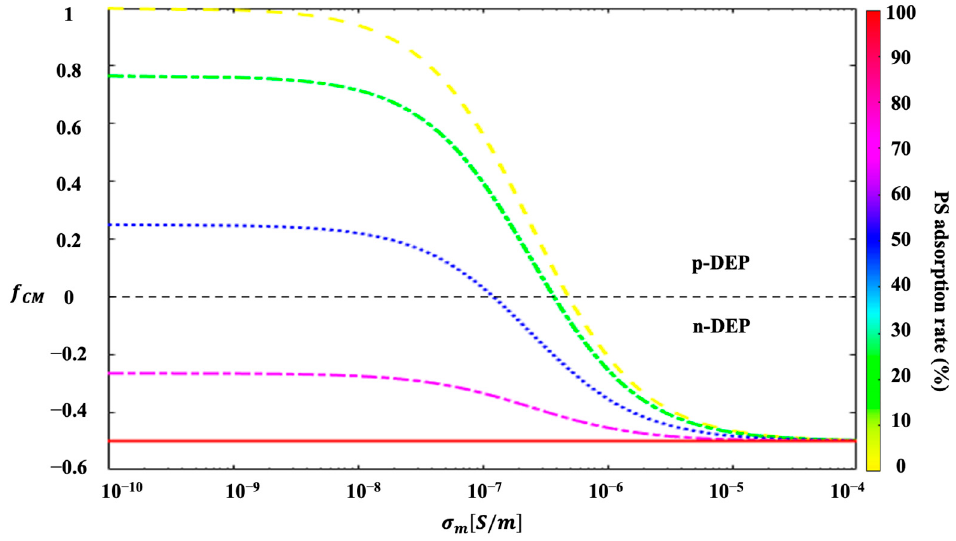
Figure 5. The CM factor of 3-micrometer Chlorella coated with various different coverage levels of PS particles, which varied with the electrical conductivity of the surrounding medium. The thickness of the PS-particle coating was 0.6 µm.